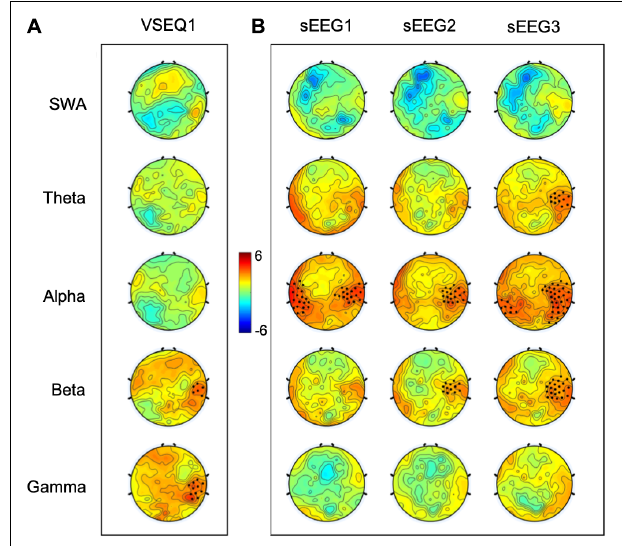
FIGURE 2 | T-maps of the comparison between the last and first VSEQ1 sequences learned by the participants (A) and between sEEG activity recorded after each VSEQ block and sEEG0 baseline recording (B) in five frequency ranges. Black dots highlighted significant clusters of electrodes ( p < 0.05, non-parametric cluster-based permutation testing).